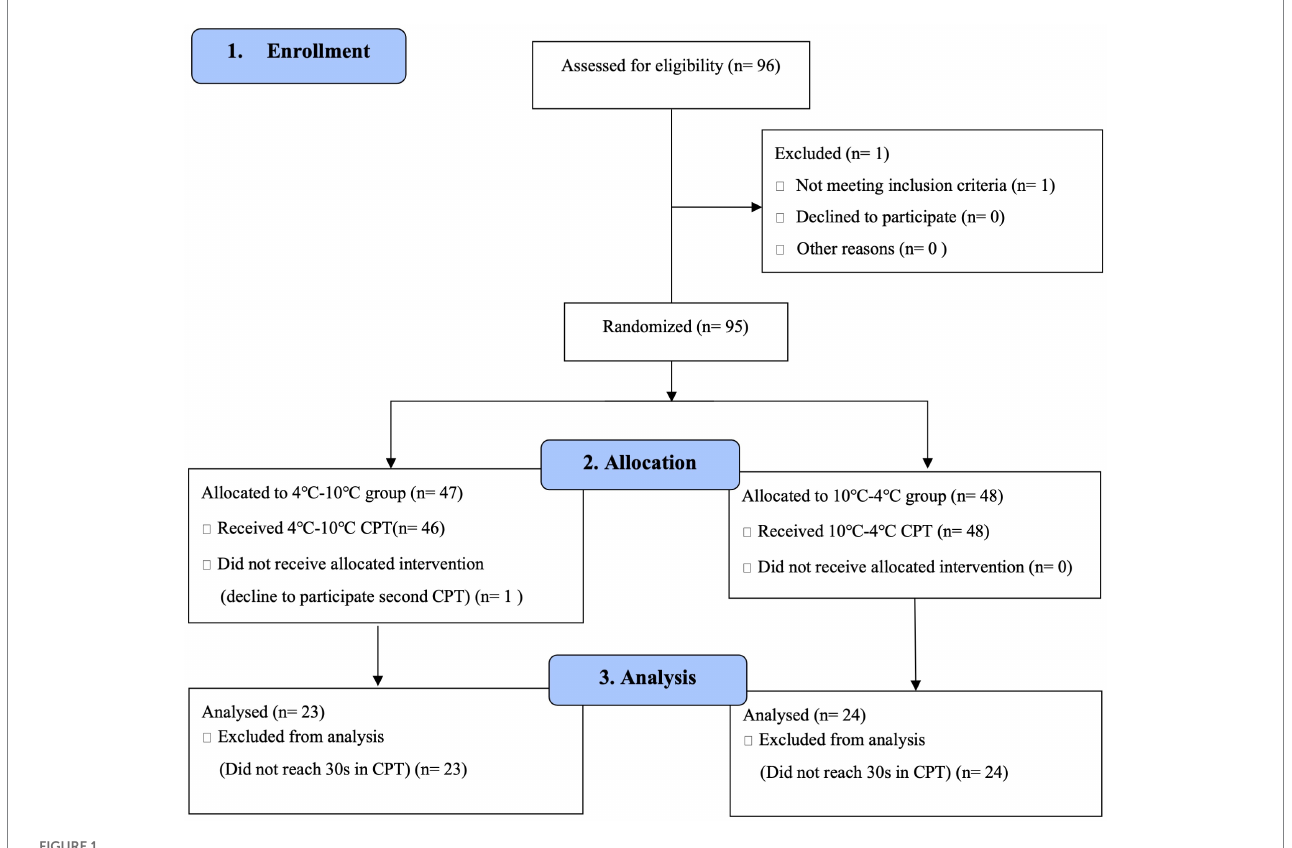
FIGURE 1 CONSORT flowchart of this